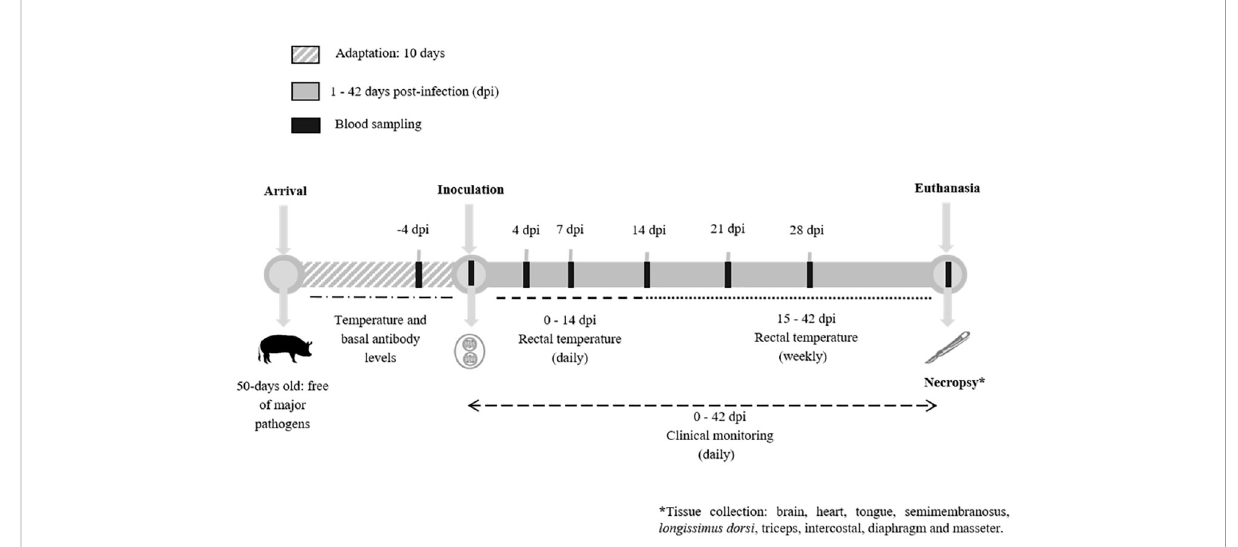
FIGURE 1 Experimental design of Toxoplasma gondii infections in piglets. Timeline, clinical monitoring and sampling throughout the experimental infection of piglets with T. gondii